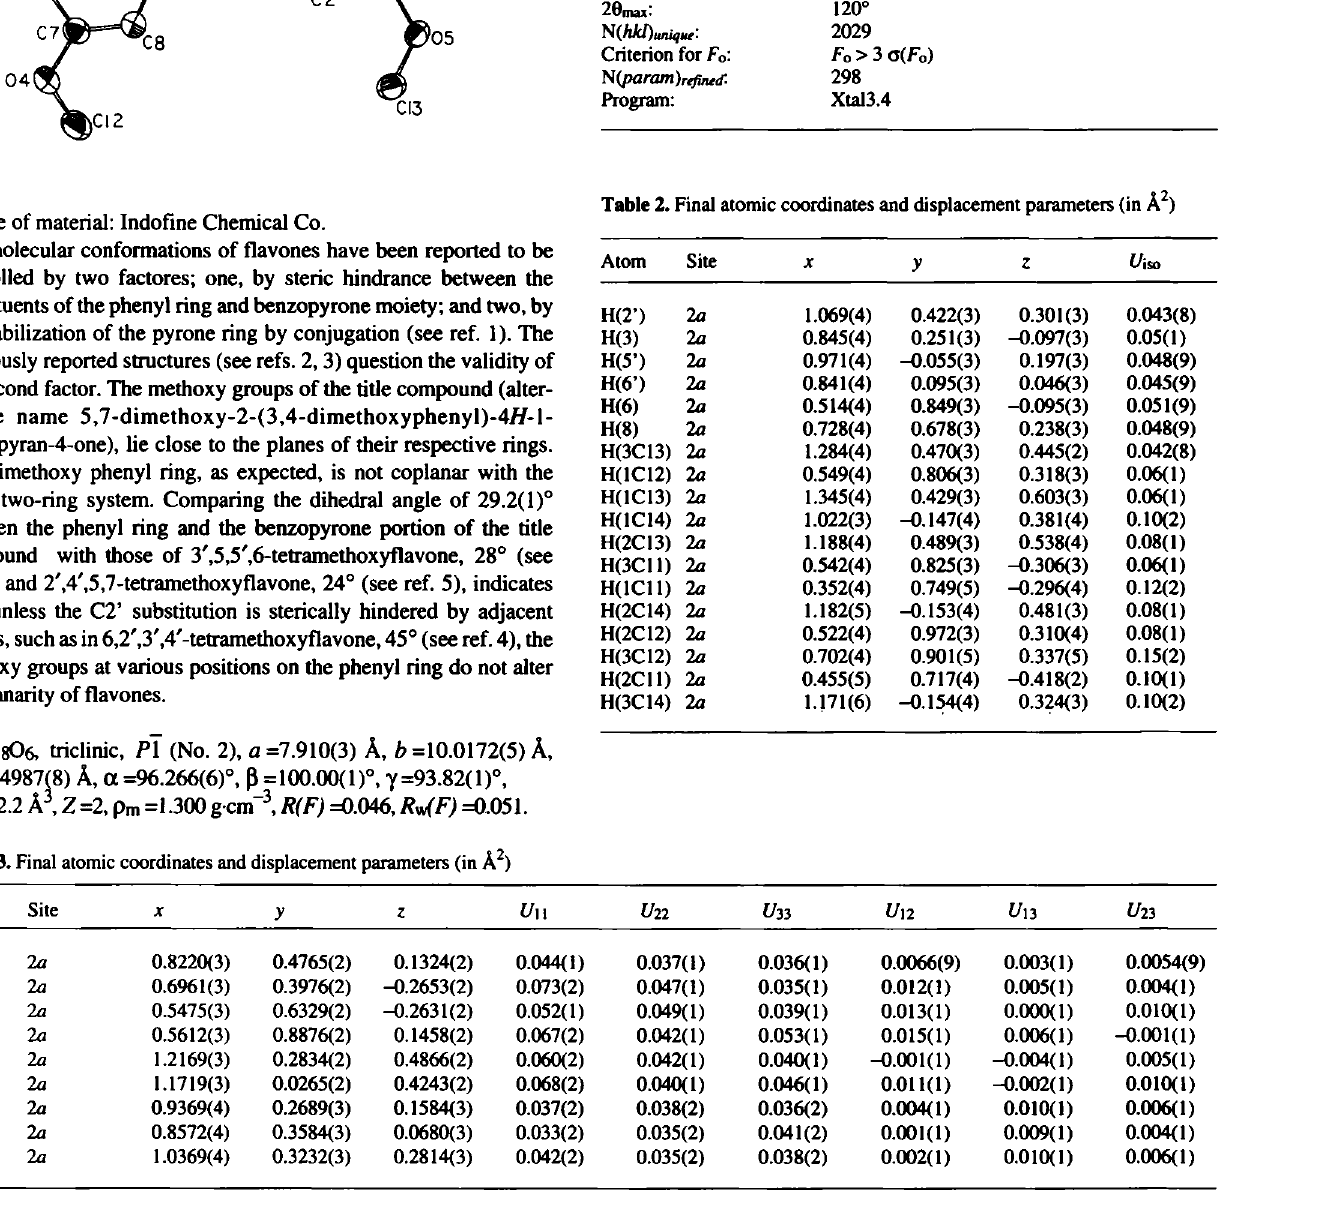
Table 1. Parameters used for the X-ray data collection Crystal: Wavelength: μ: Diffractometer: